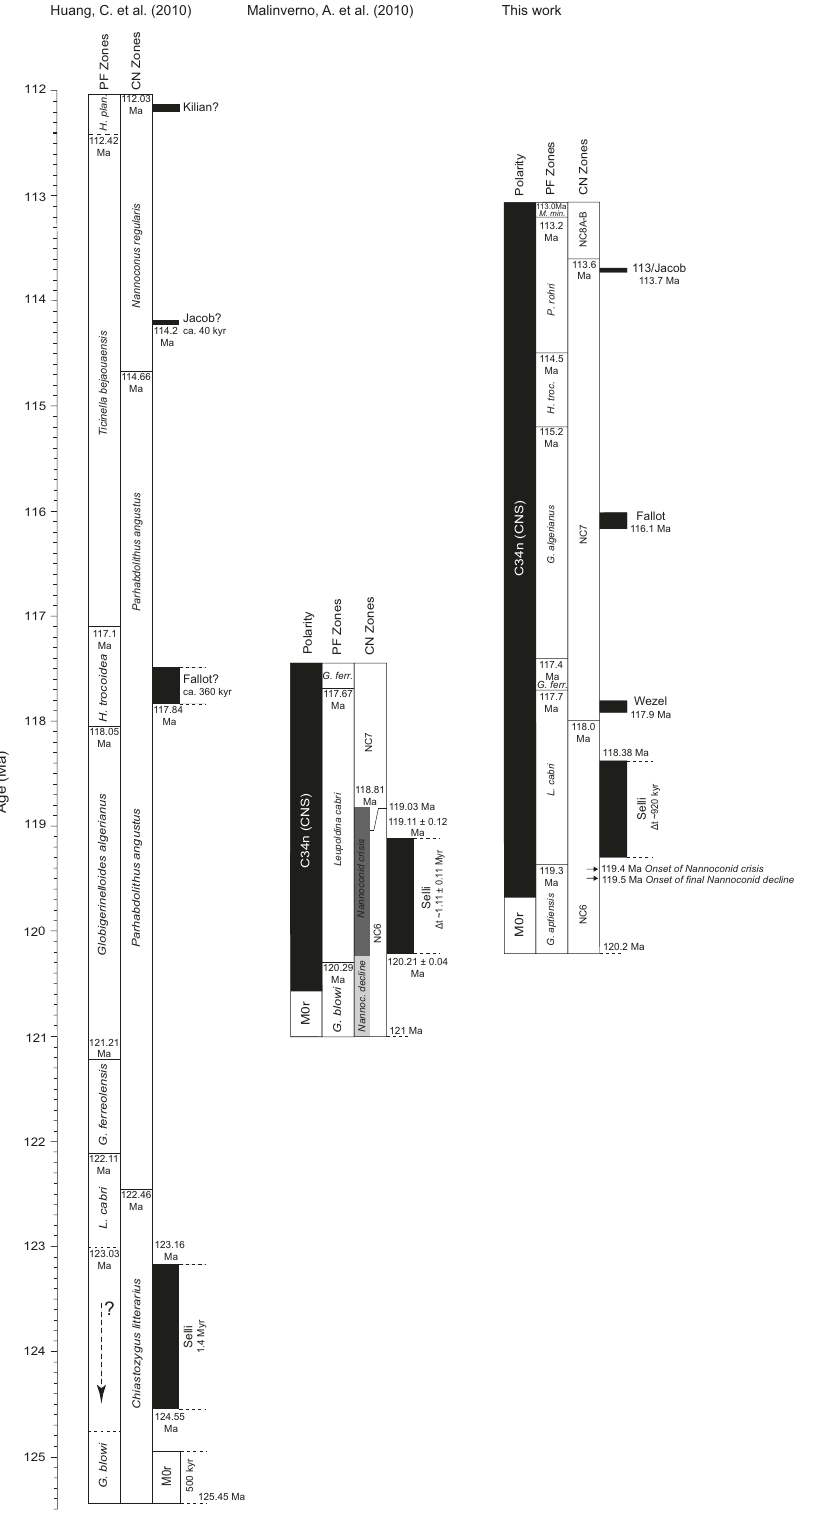
NATURE COMMUNICATIONS| (2022) 13:2941